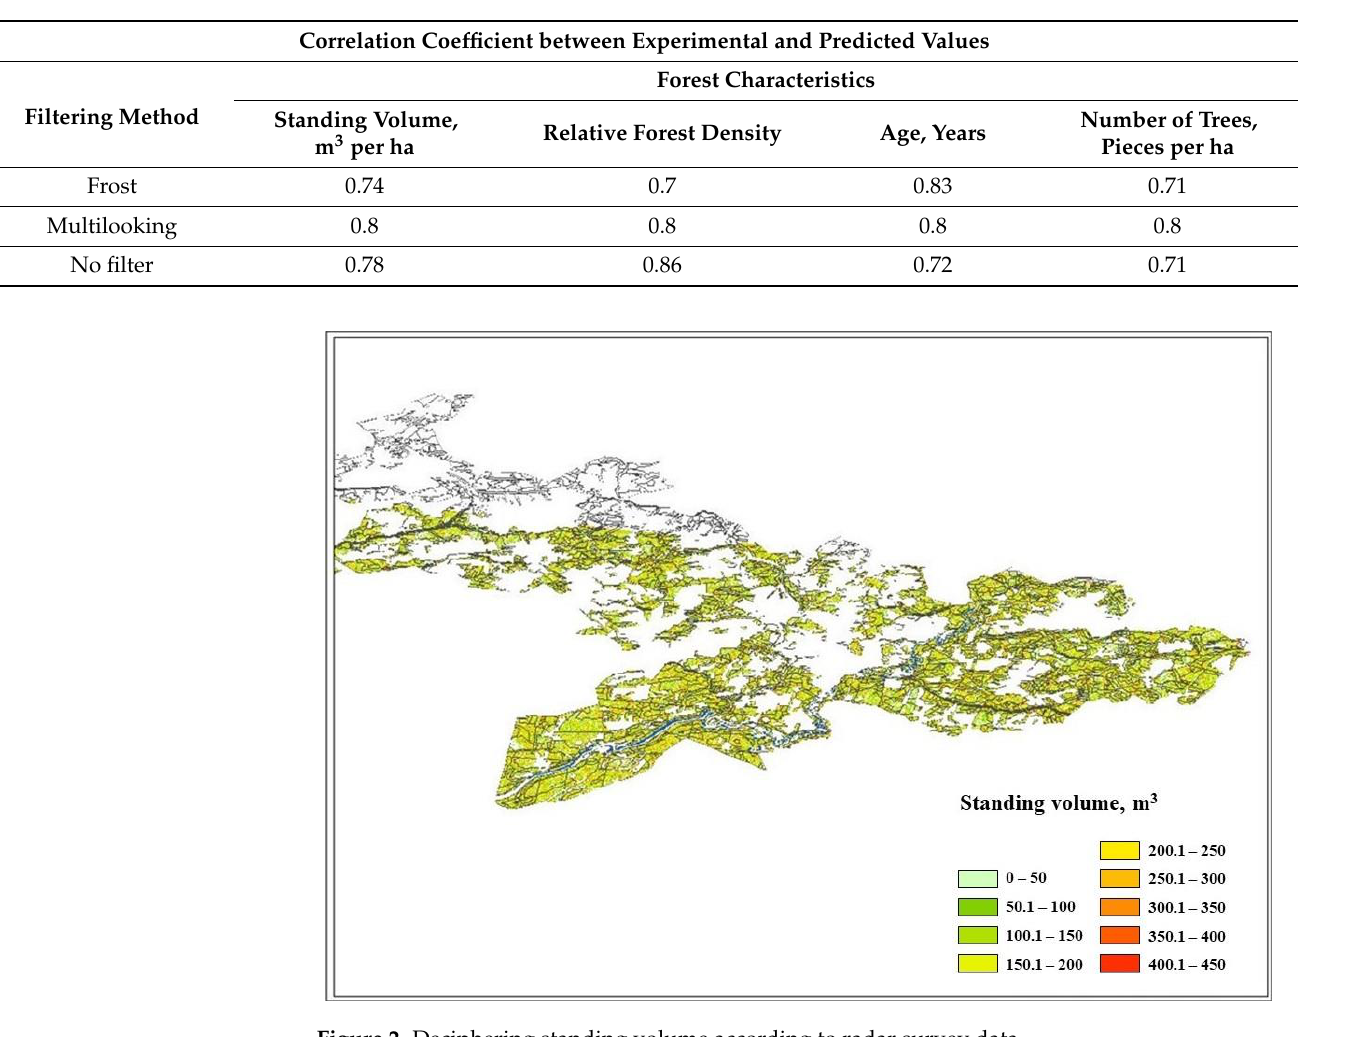
Table 1. Efficiency of determining forest characteristics using various methods of preliminary radar image processing.